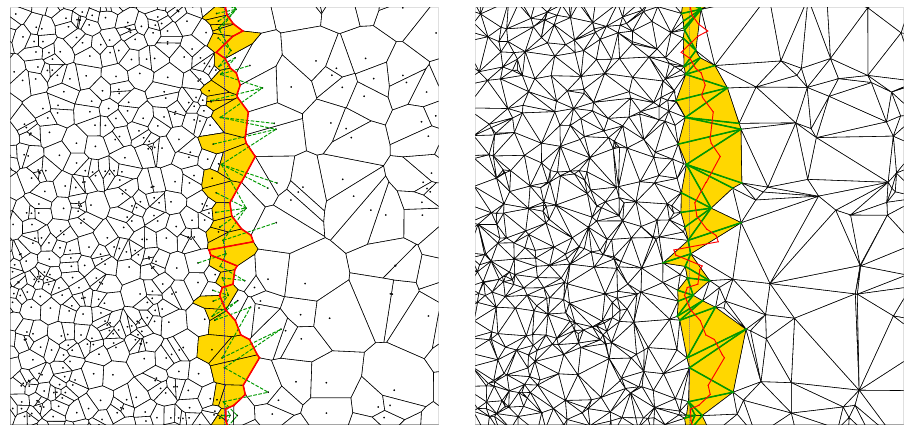
Figure 4 . Left: the Voronoi tessellation of the data shown in figure 3 illustrating the relationships between Boundary Voronoi Cells (yellow-shaded), Boundary Voronoi Edges (red solid lines) and Boundary Delaunay Edges (green dashed lines). Right: Delaunay tessellation of the data shown in figure 3 illustrating the relationships between Boundary Delaunay Triangles (yellow-shaded), Boundary Voronoi Edges (red solid lines) and Boundary Delaunay Edges (green solid